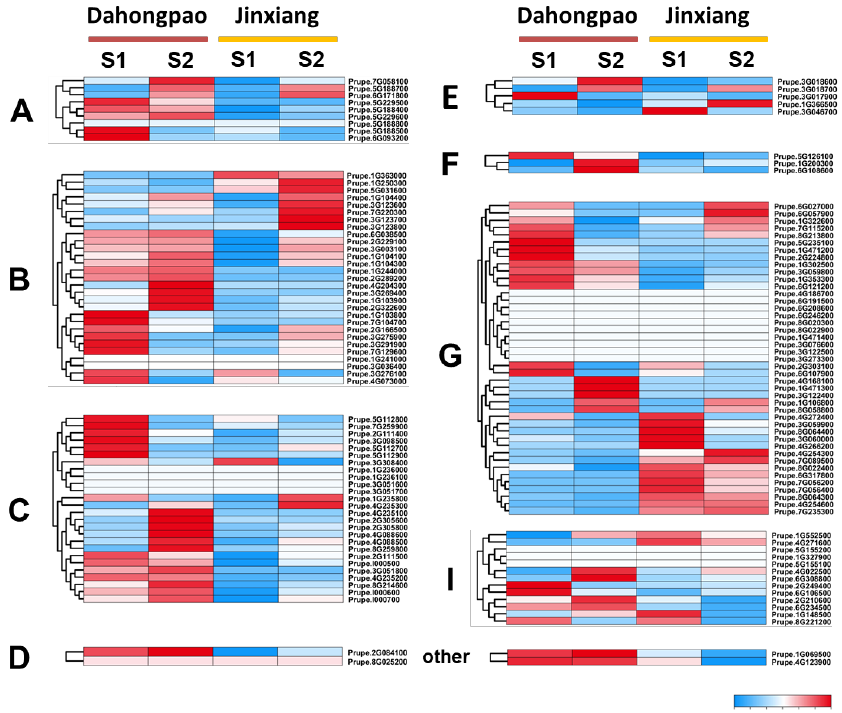
Figure 4. Expression profile of PpABC genes during fruit development of peach. Transcript expression levels were determined during two developmental stages, S1 (green stage at 65 DAFB) and S2 (color break stage at 85 DAFB). The FPKM values were used to generate a heatmap with hierarchical clustering analysis. A–G and I indicated the eight subfamilies of PpABC genes. The color scale displaying the expression levels ( −1 .5 to 1.5) was indicated.